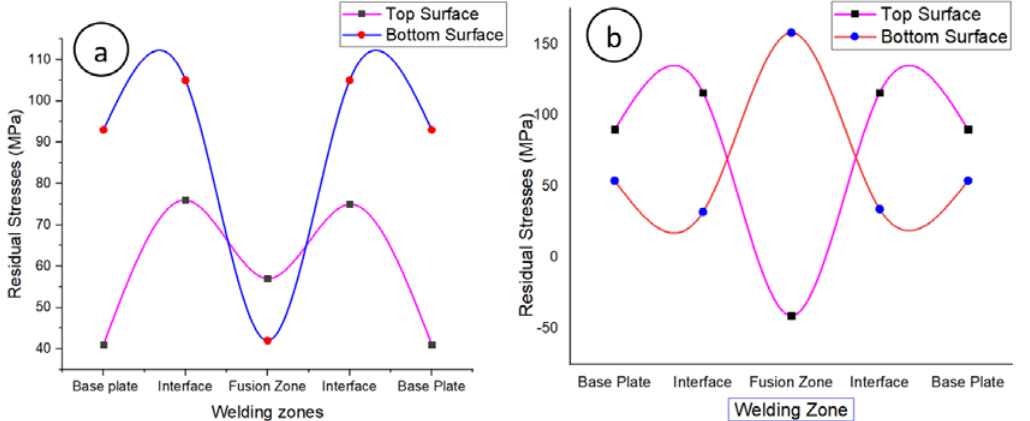
Figure 13. Residual stress distribution of the top and bottom surface of the final welds: ( a ) joint 1 and ( b ) joint 3.